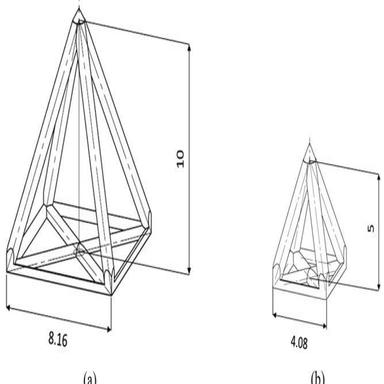
Two types of pyramids: a) big; b) small.